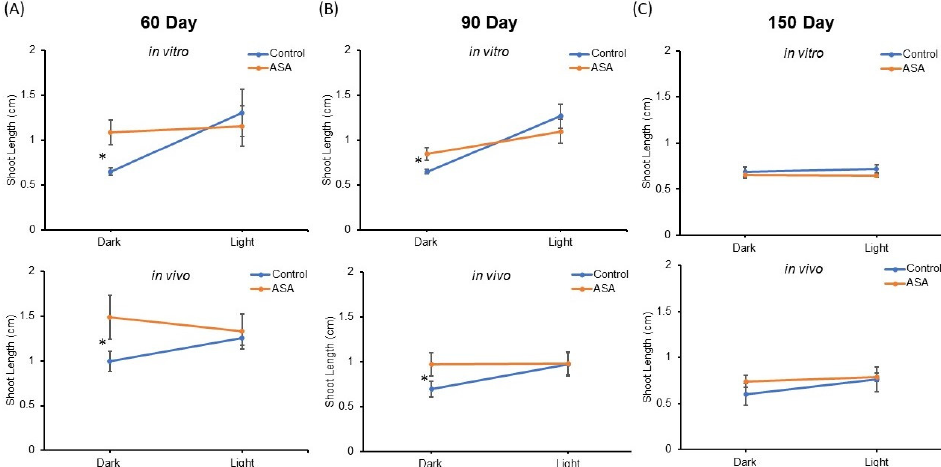
Figure 4. Comparison of shoot length after 15 days culture on MS medium. Synseeds derived from in vitro or in vivo plants were stored at 6 °C for 60 ( A ), 90 ( B ), or 150 ( C ) days under 50 μ mol s − 1 m − 2 light and an 18/6 h photoperiod or dark conditions with or without 25 µ M acetylsalicylic acid (ASA). Error bars represent standard error ( n = 5 ≤ 10). Two factor ANOVA model was used to identify an interaction between light and ASA treatments. Differences between mean shoot length are compared with Tukey’s test denoted by an asterisk ( p -value ≤ 0.05).